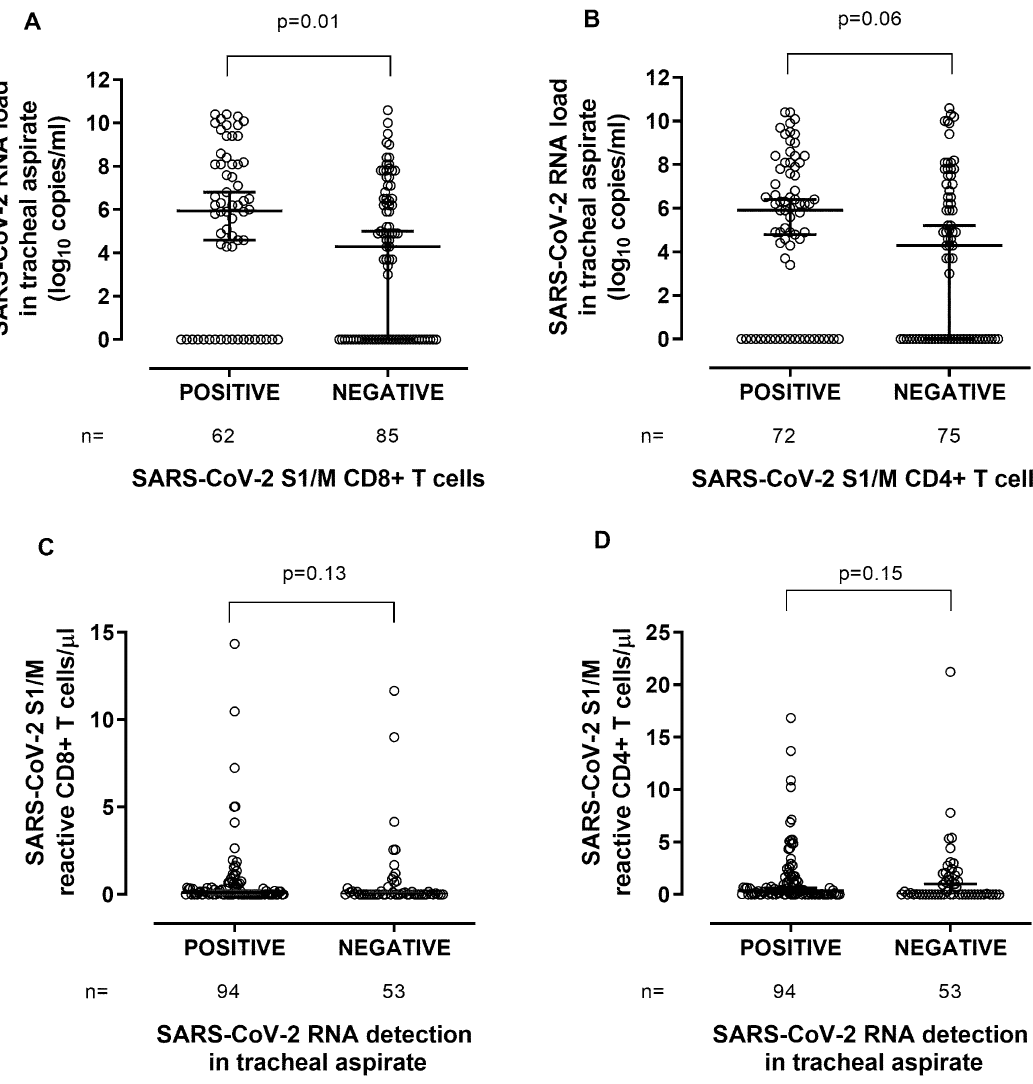
Figure 2. Relationship between SARS-CoV-2 RNA load in the lower respiratory tract and peripheral blood levels of SARS-CoV-2 S1/M-reactive IFN-γ T cells. SARS-CoV-2 RNA load in tracheal aspirates in patients with or without concurrent detection of peripheral blood SARS-CoV-2 S1/M-reactive IFN-γ CD8 + ( A ) or CD4 + ( B ) T cells and SARS-CoV-2 S1/M-reactive IFN-γ CD8 + ( C ) or CD4 + ( D ) T-cell levels in peripheral blood according to the presence or absence of detectable SARS-CoV-2 RNA in paired tracheal aspirates. Bars represent medians and 95% CI values . P values for comparisons are shown.